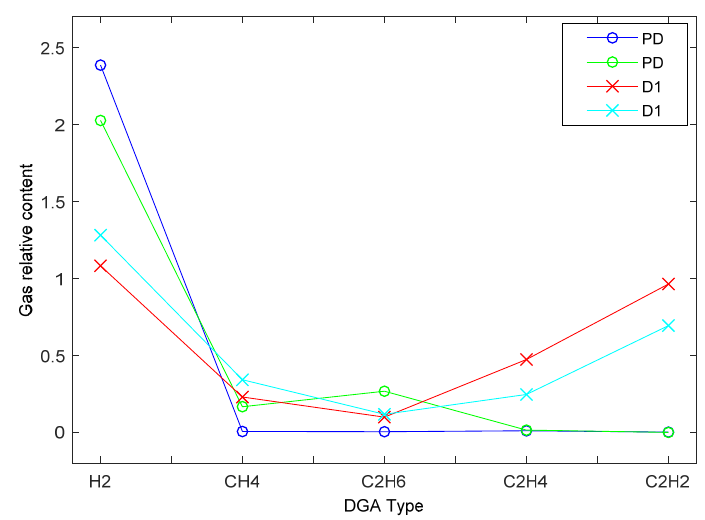
Figure 4. Change curve of fitness with iteration times.